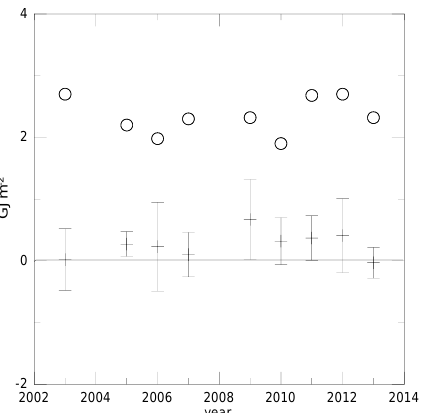
Figure 3. Annual averages of precipitation (m, circles), water in- filtration fraction (squares) and aridity index (triangles) with esti- mated maximum uncertainties. The continuous ( P ) dashed (WIF) and dash-dotted (AI) lines are least squares linear